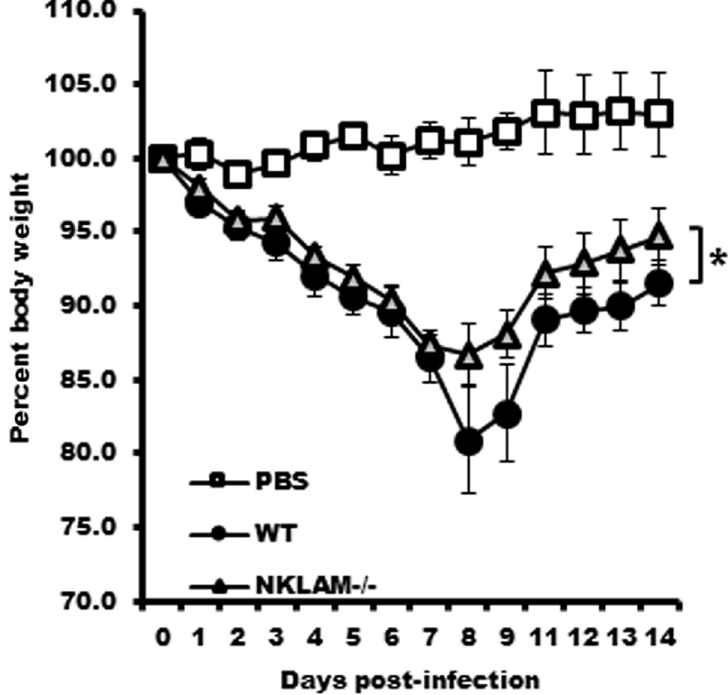
Fig 2. NKLAM -/- mice experience less weight loss during SeV infection. All mice were infected with SeV (500 pfu/ gram body weight) and their weight was monitored daily for 14 days. PBS (30 μ L) was administered to uninfected control mice. n = 10 mice per group; p = 0.0004, Two-factor